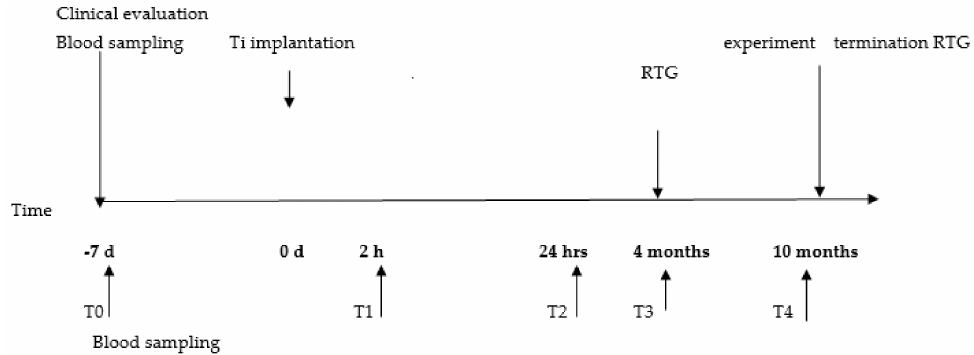
Figure 12. Timeline for clinical evaluation, surgery and blood